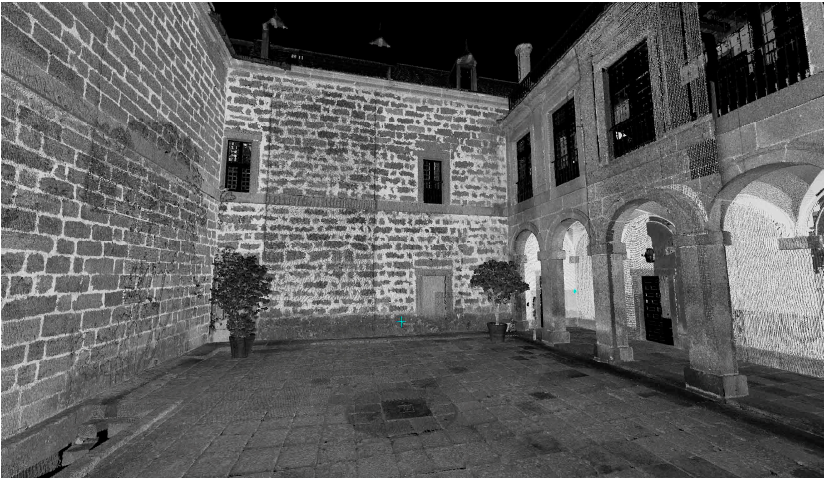
Figure 9. Scanned image in shades of grey of the patio or cloister in the Botica , showing the south wall and the blind east wall on the right side of the image. The arcade corresponds to the west gallery. For instance, the east wall as shown on the left in Figure 9 is represented in the Séptimo diseño (Figure 8) as a gallery with open lintel openings within a false arcade. The same design is repeated on the south wall. However, a careful examination of Perret’s engraving shows that the interior of the windows is lined with an intensity that is different on both walls which does not depend on the incident light.